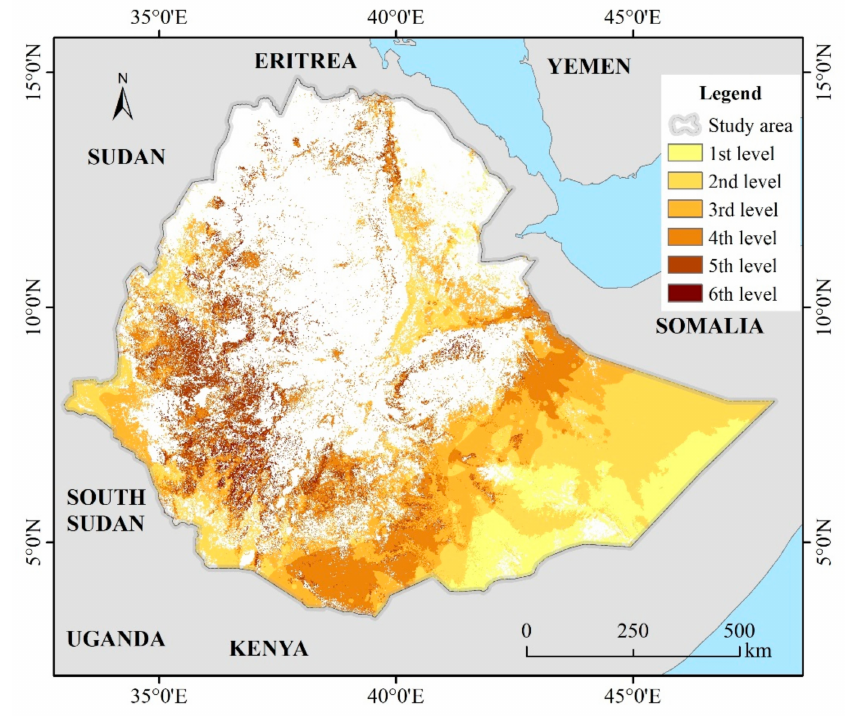
Figure 9. The adaptability zoning map of grassland ecosystem in